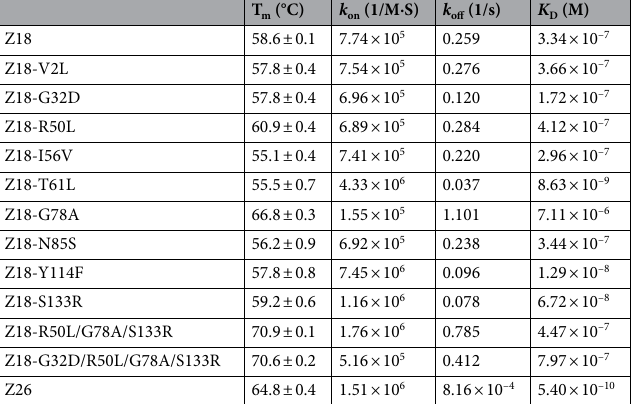
Table 1. Thermal stabilities and binding affinities of Z18 mutants and Z26.